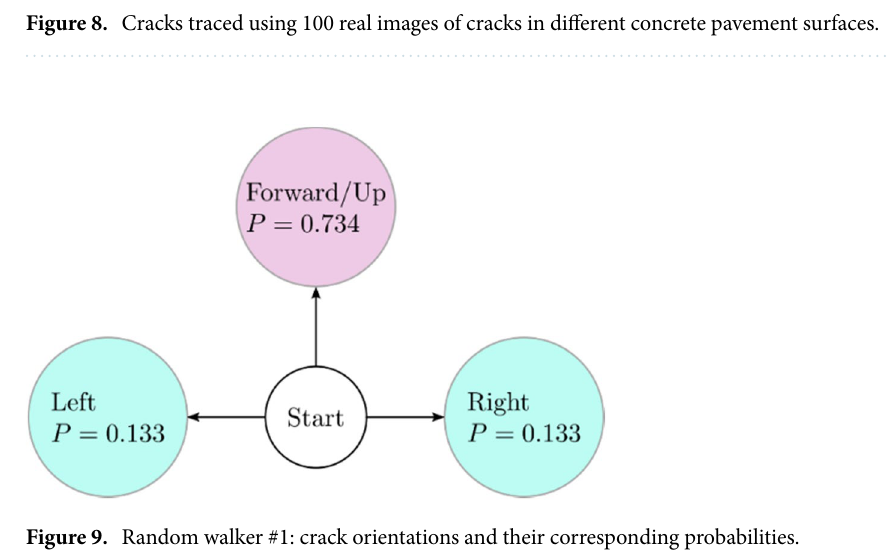
Figure 9. Random walker #1: crack orientations and their corresponding